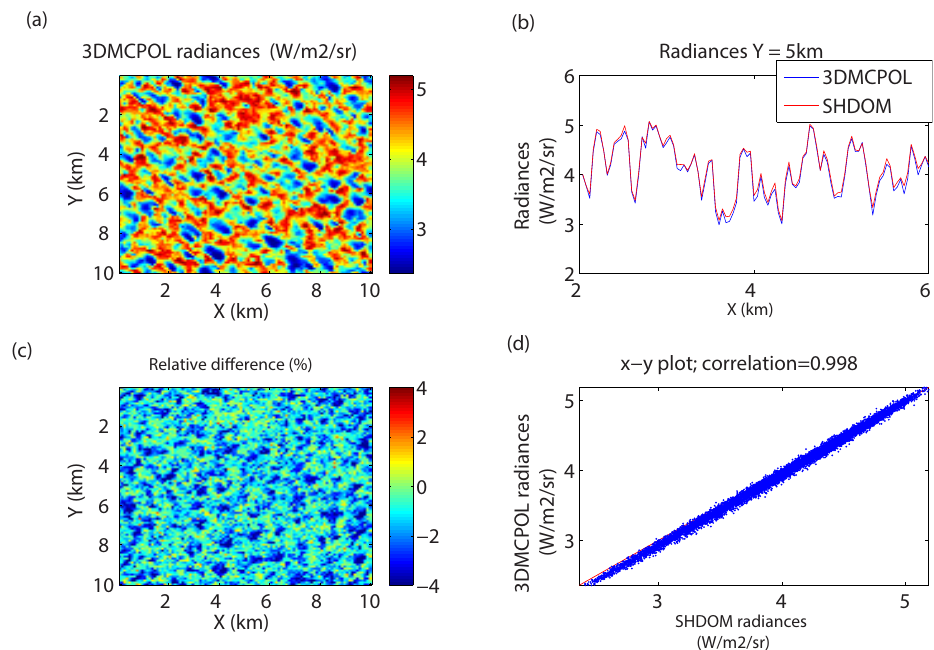
Figure 6. Comparisons of 3DMCPOL and SHDOM radiance simulations at 10 . 60µm for $ 0 = 0 . 5, τ c = 1 . 8 and for θ v = φ v = 0 ◦ . (a) 3DM- CPOL TOA radiance field simulation at the nadir; (b) 3DMCPOL and SHDOM radiances along the x axis for Y=5km; (c) relative differences ( 3DMCPOL − SHDOM / 3DMCPOL ) × 100(%) between 3DMCPOL and SHDOM radiances; (d) 3DMCPOL-SHDOM correlation